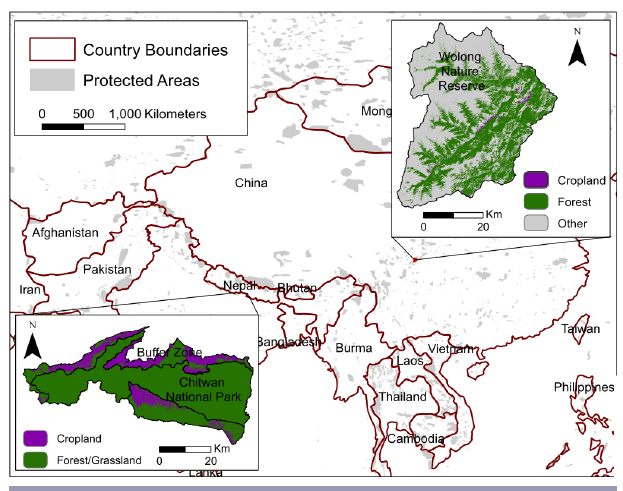
Fig. 2. Locations of the two focal coupled human and natural systems (CHANS) examined: Wolong Nature Reserve in China and Chitwan National Park in Nepal. Forested and cultivated areas are shown for each CHANS. The locations of many other protected areas are indicated in